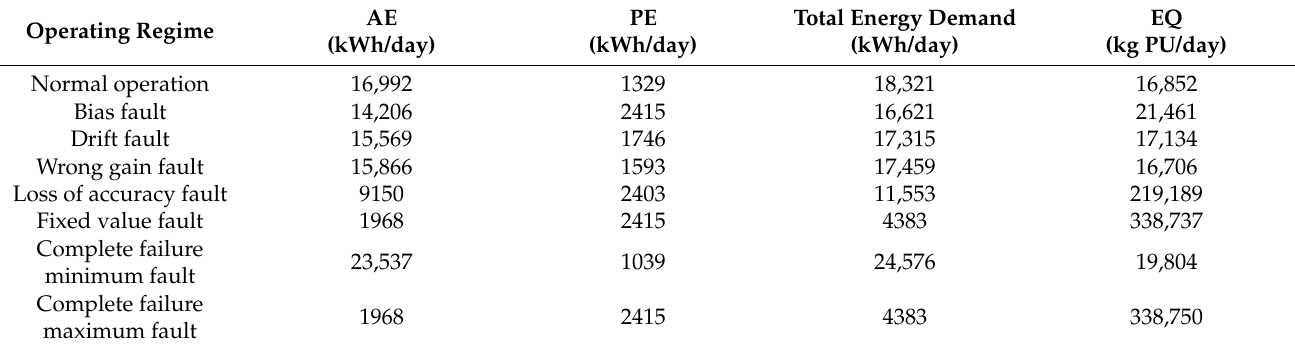
Table 2. Values of the performance indices for the normal and faulty operation